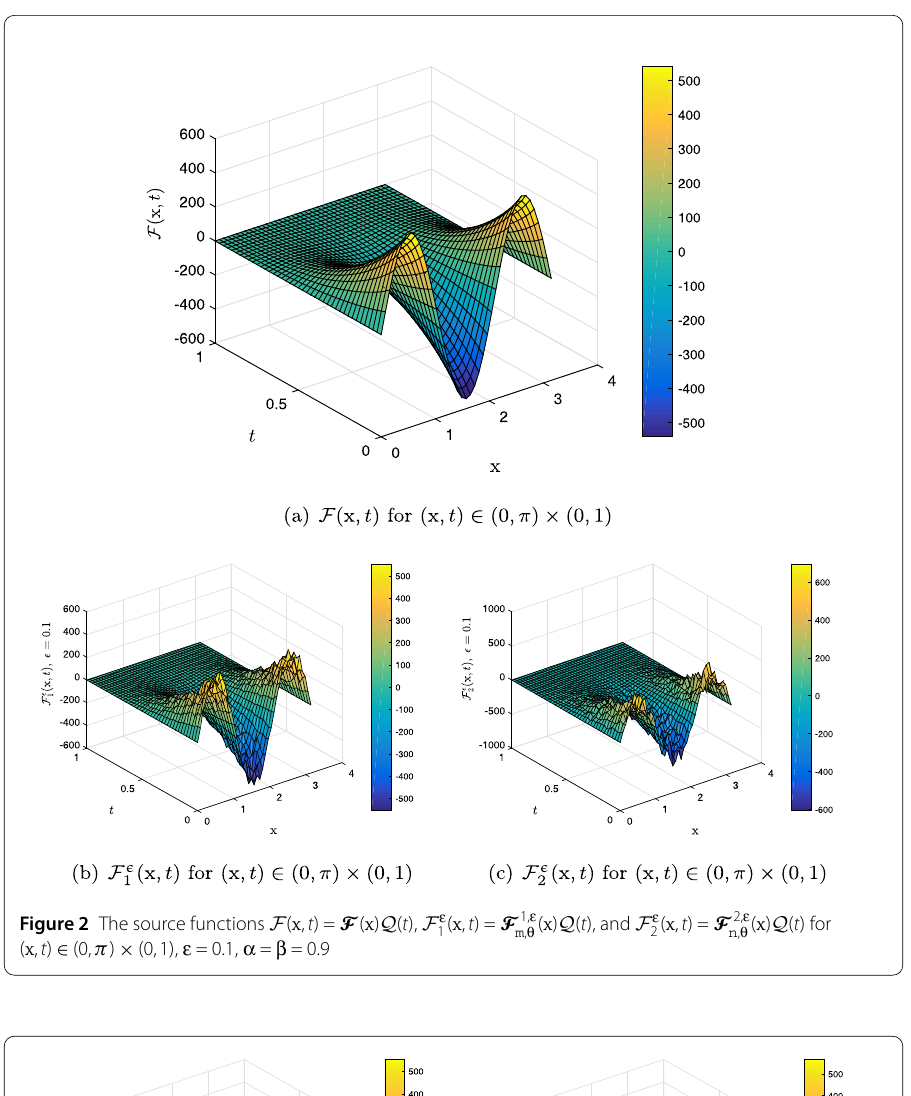
( x ) Q ( t ), and F ε 2 ( x , t ) = F 2, ε ( x ) Q ( t ) for m , θ n , θ